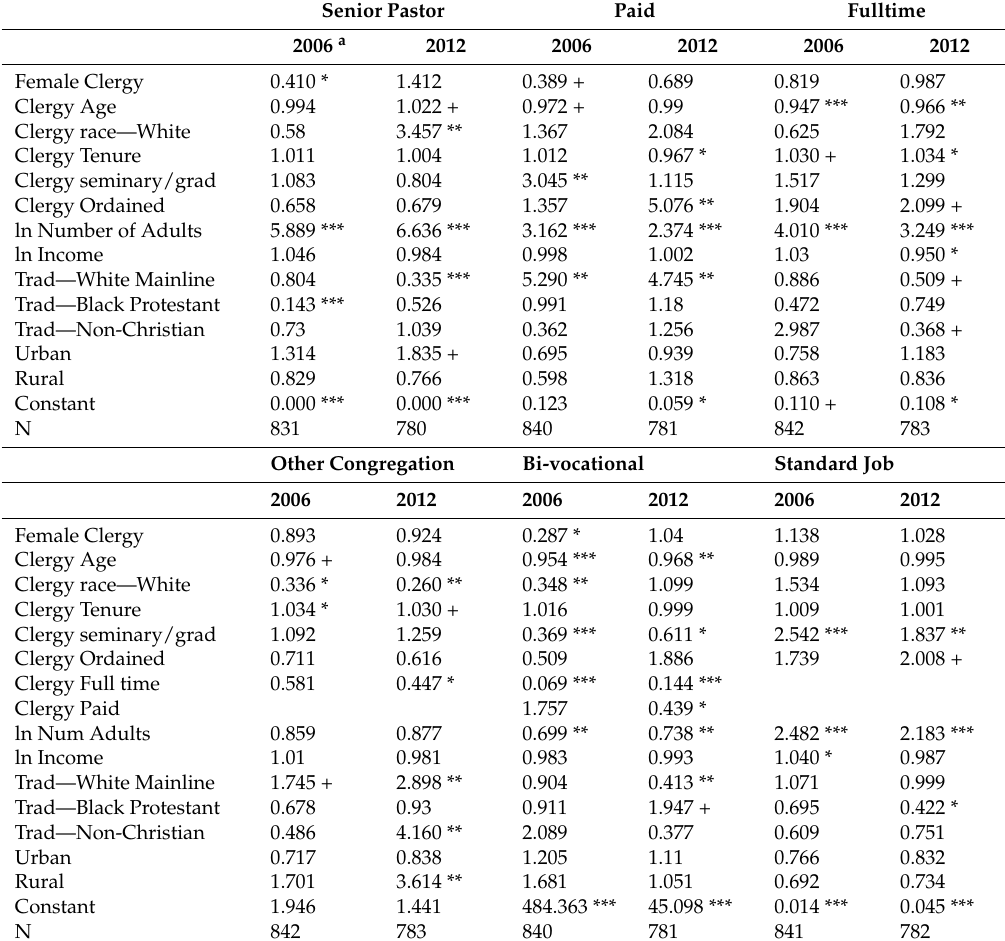
Table 6. Logistic Regression. Clergy Characteristics Influencing Job Status Features: 2006 and